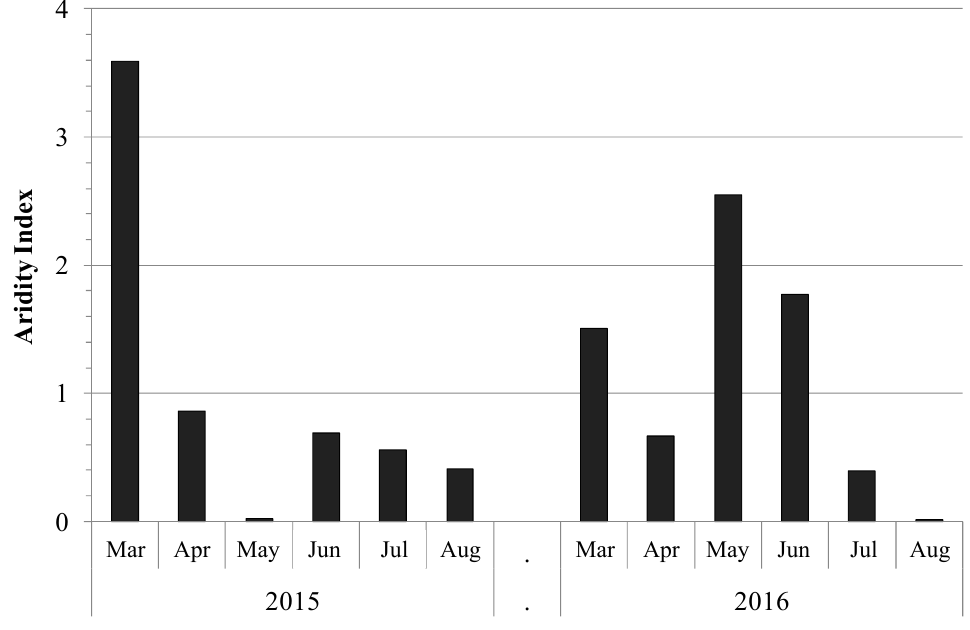
Figure 1. Aridity index throughout the periods of study in 2015 and 2016.